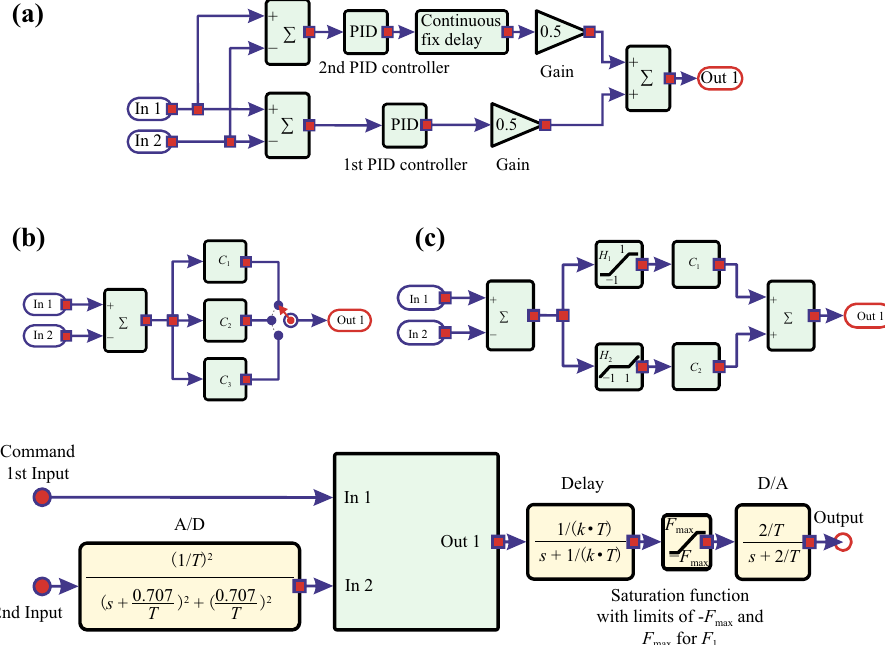
Fig. 4 Block diagram of the master controller for speed regulation built upon a parallel arrangement of two PID controllers, b bumpless transfer method, and c two nonlinear dynamic compensators connected in